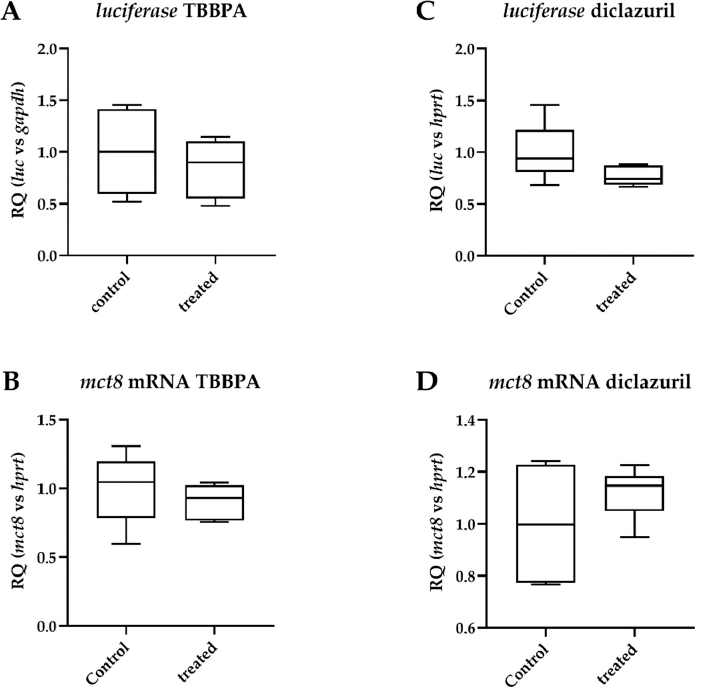
Figure 6. Changes in parameters of thyroid hormone action in the cerebral cortex after disruptor treatment. Male THAI mice treated orally for 6 days with 150 mg/bwkg/day of TBBPA in corn oil containing 2% Et-OH or for 5 days with 10 mg/bwkg/day of diclazuril as a saline suspension; thyroid hormone action quantified with luciferase mRNA levels; ( A , B ) TBBPA; ( C , D ) diclazuril; ( A ) luciferase mRNA after TBBPA; ( B ) mct8 mRNA after TBBPA; ( C ) preamplified luciferase mRNA after diclazuril; ( D ) mct8 mRNA after diclazuril. n = 5–6 mice/group; figure shows Tukey Box Plots, α = 0.05. Neuronal TH action is heavily regulated by type 3 deiodinase (D3), the main TH- degrading enzyme [38]. To further characterize the cortical effects of TBBPA or diclazuril, we also studied how dio3 was impacted. TBBPA exerted a tissue-specific effect on dio3 expression; it was decreased in the cortex, increased in the hippocampus and remained unchanged in the pituitary and liver (Figure 7A).